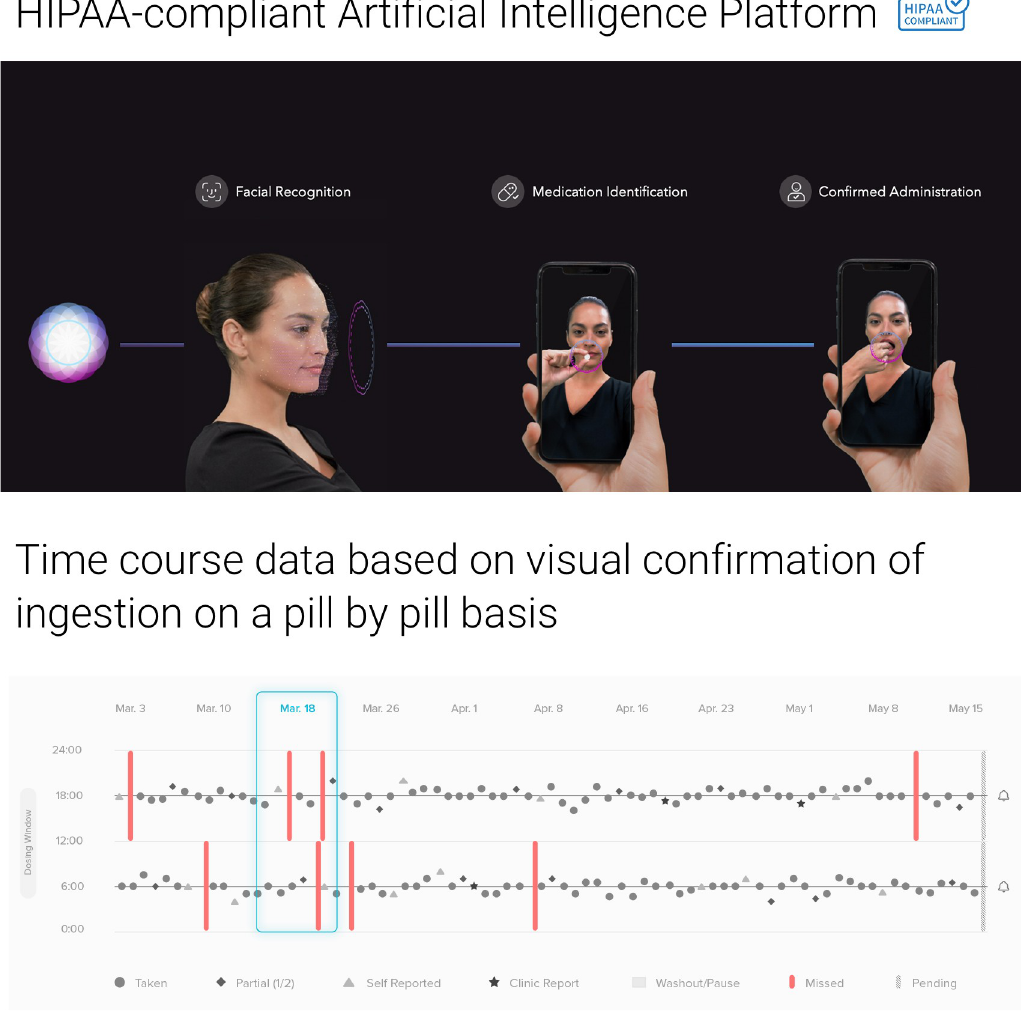
Fig 1. AiCure artificial intelligence platform. Software automatically observes and confirms patient, medication, and ingestion. HIPAA Health Insurance Portability and Accountability Act. Source: AiCure, LLC (New York, NY) with written permission to use and adapt.